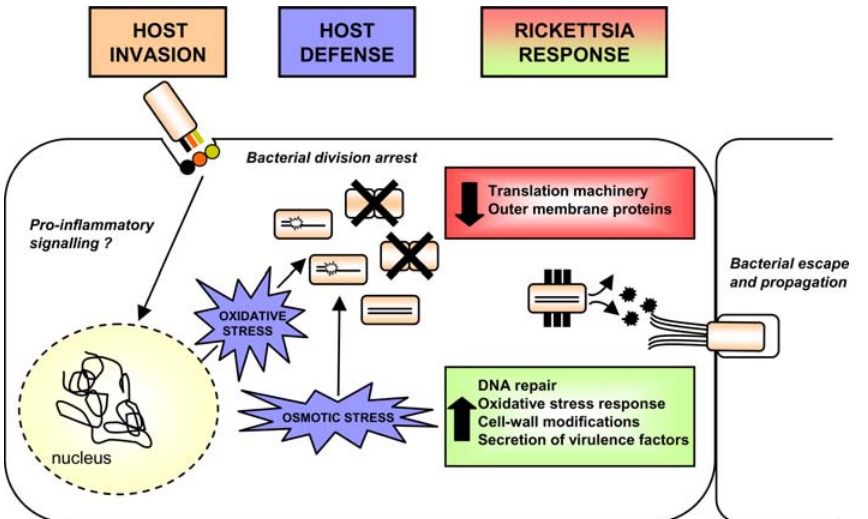
Figure 5. Schematic representation of the interaction between R.conorii and its host cell at the site of inoculation. Intracellular uptake of R. conorii by induced phagocytosis [46] may activate signalling pathways in the host cells which in turn display several mechanisms to eliminate invading bacteria among which oxidative and osmotic stress. As shown by the work presented in this paper, these events induce a strong down- regulation of R. conorii transcripts, mainly of those involved in bacterial replication and classified within translation and cell wall membrane COGs. These pathogenic bacteria therefore evade the host defense through the up-regulation of several factors counteracting DNA damages and through variations of dominant surface antigens allowing to avoid host recognition. The secretion of virulence determinants is also likely to favour survival and colonization of the host.